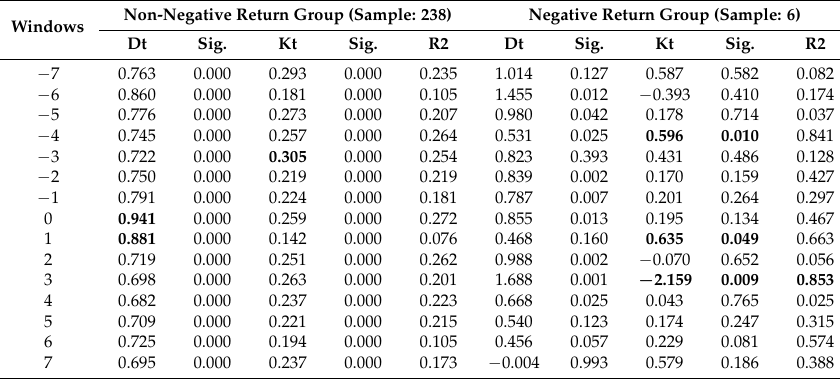
Table 5. Results of the model for announcement samples in 2014 in the Second-board Stock market: Positive Earning Group against Negative Earning